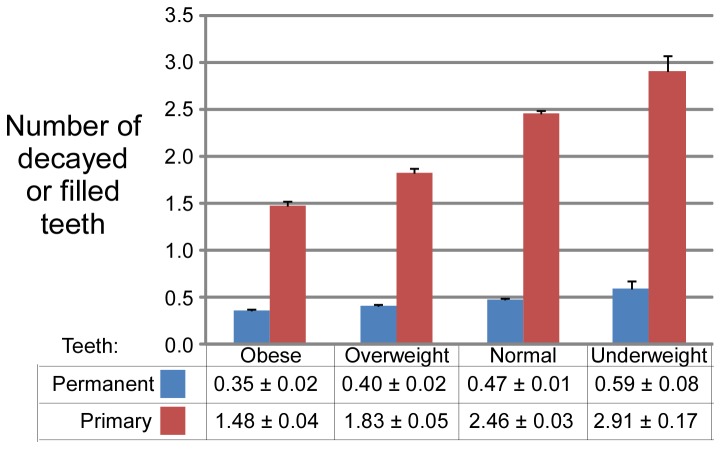
Severity of dental decay measured as mean number of decayed or filled teeth in both permanent and primary dentition of children (mean ± S.E.M.) of different body weight categories.